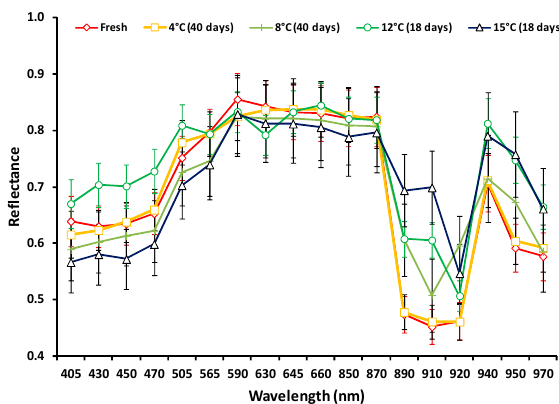
Figure 1. Reflectance spectra (mean ± standard deviation values) of selected vanilla cream samples corresponding to different storage conditions.